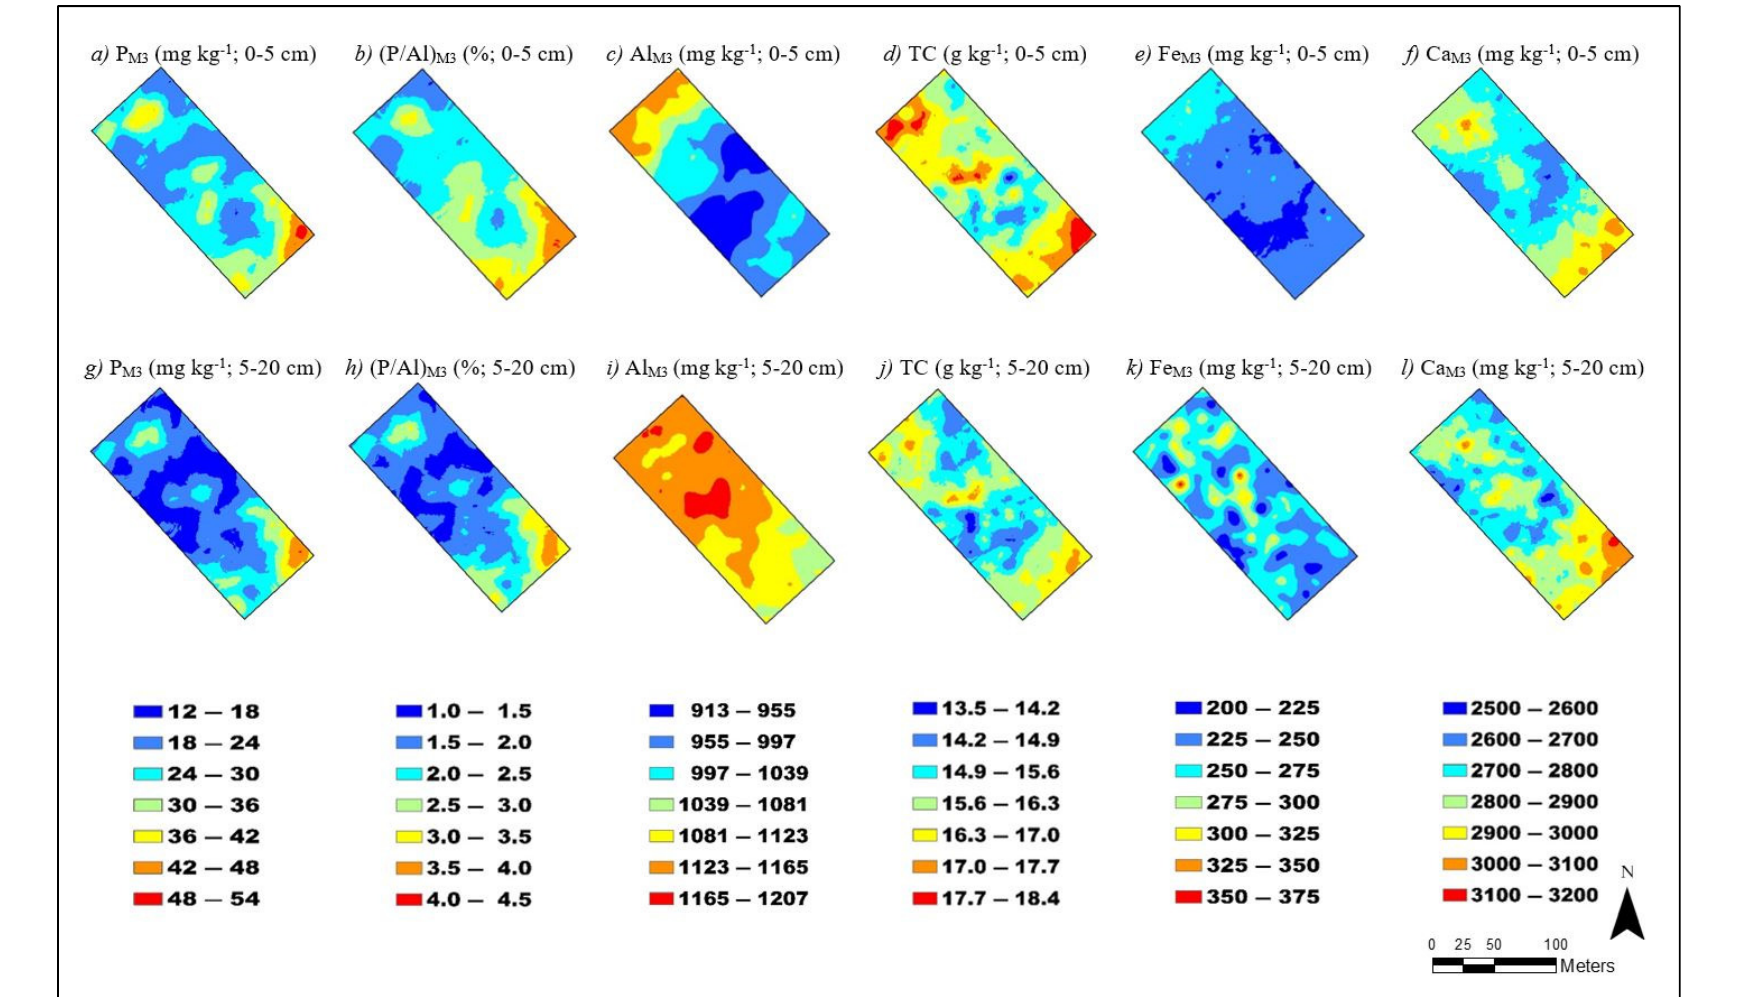
Figure 3. Spatial distribution maps of P M3 ( a , g ), (P/Al) M3 ( b , h ), Al M3 ( c , i ), TC ( d , j ), Fe M3 ( e , k ) and Ca M3 ( f , l ) for the 0–5 cm and 5–20 cm soil layers in the conventional tillage field.